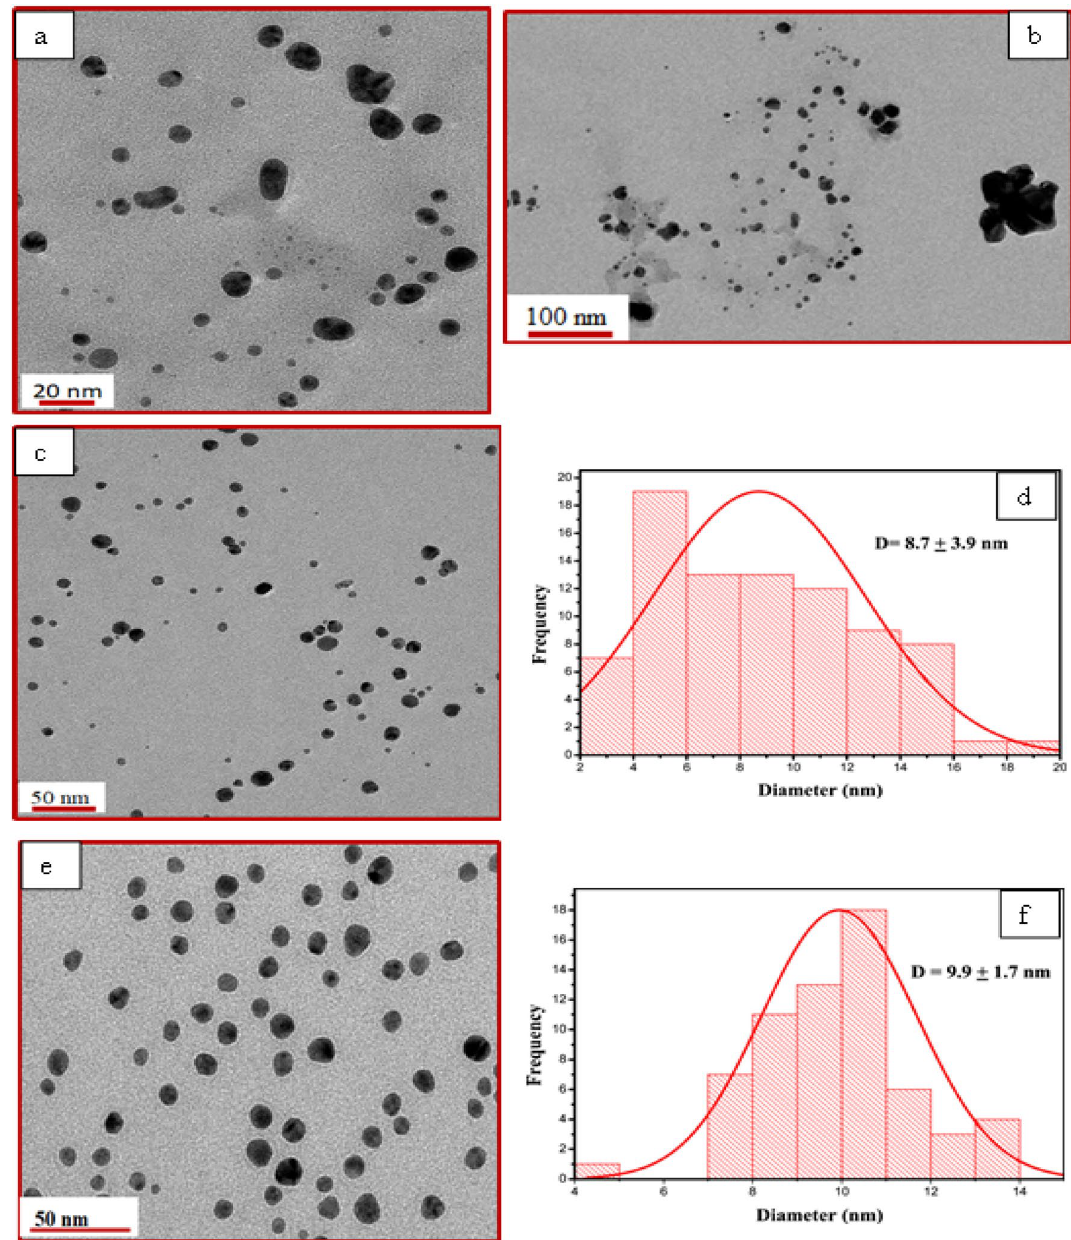
Figure 3. TEM images and histograms of the AgNPs prepared at pH 5 and 25 °C ( a , b ), pH 5 and 65 °C ( c , d ), and pH 7 and 65 °C ( e , f